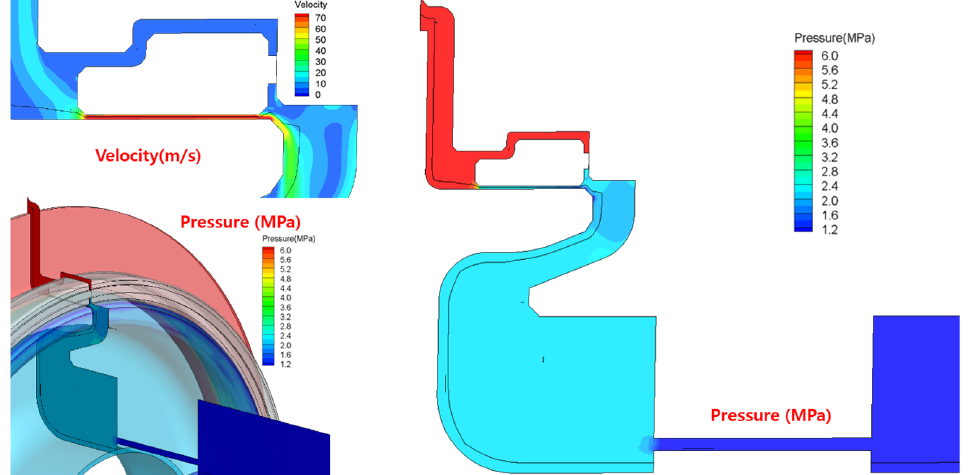
Figure 7. Static pressure (MPa) and velocity (m/s) distributions around floating ring seal at 0 rpm.